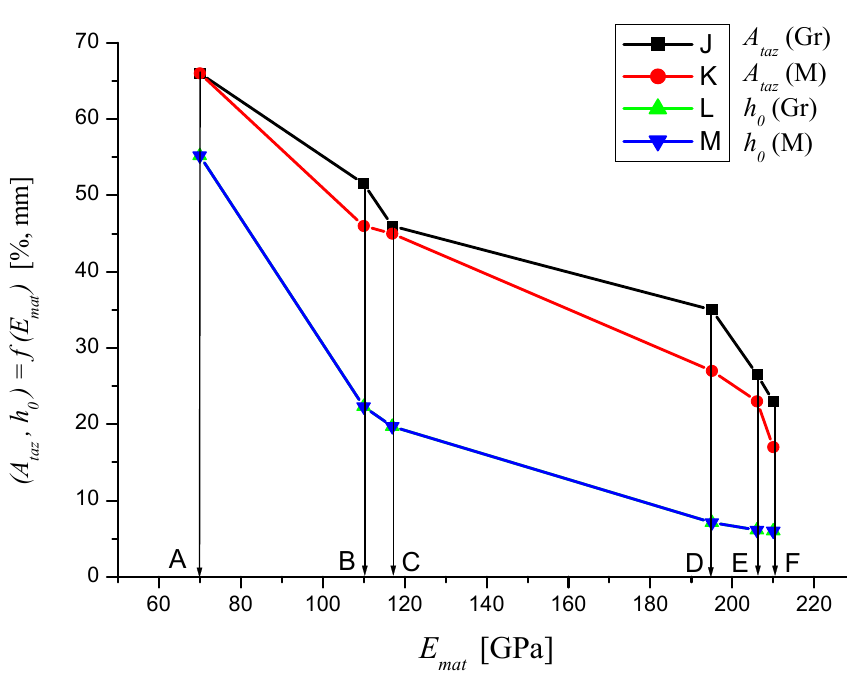
Figure 17. Dependencies of material parameters (Mes) and theoretical (Gr) for materials A—aluminium, B—titanium, C—commercially pure copper, D—AISI 304, E—commercially pure iron, F—AISI 309. Table 1. Values obtained by tensile testing and values obtained by theoretical prediction calculations. Parameter